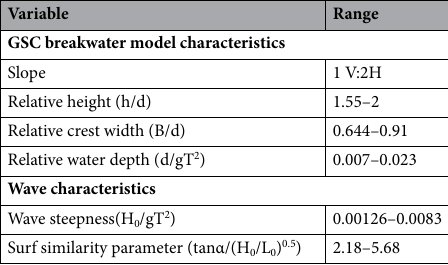
Table 2. Non-dimensional model and wave